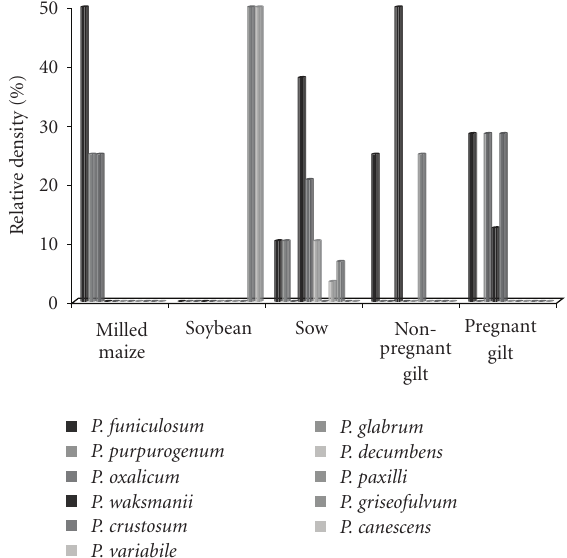
Figure 4: Relative density (%) of Penicillium spp. Isolated from raw materials and finished feed for sow at di ff erent reproductive